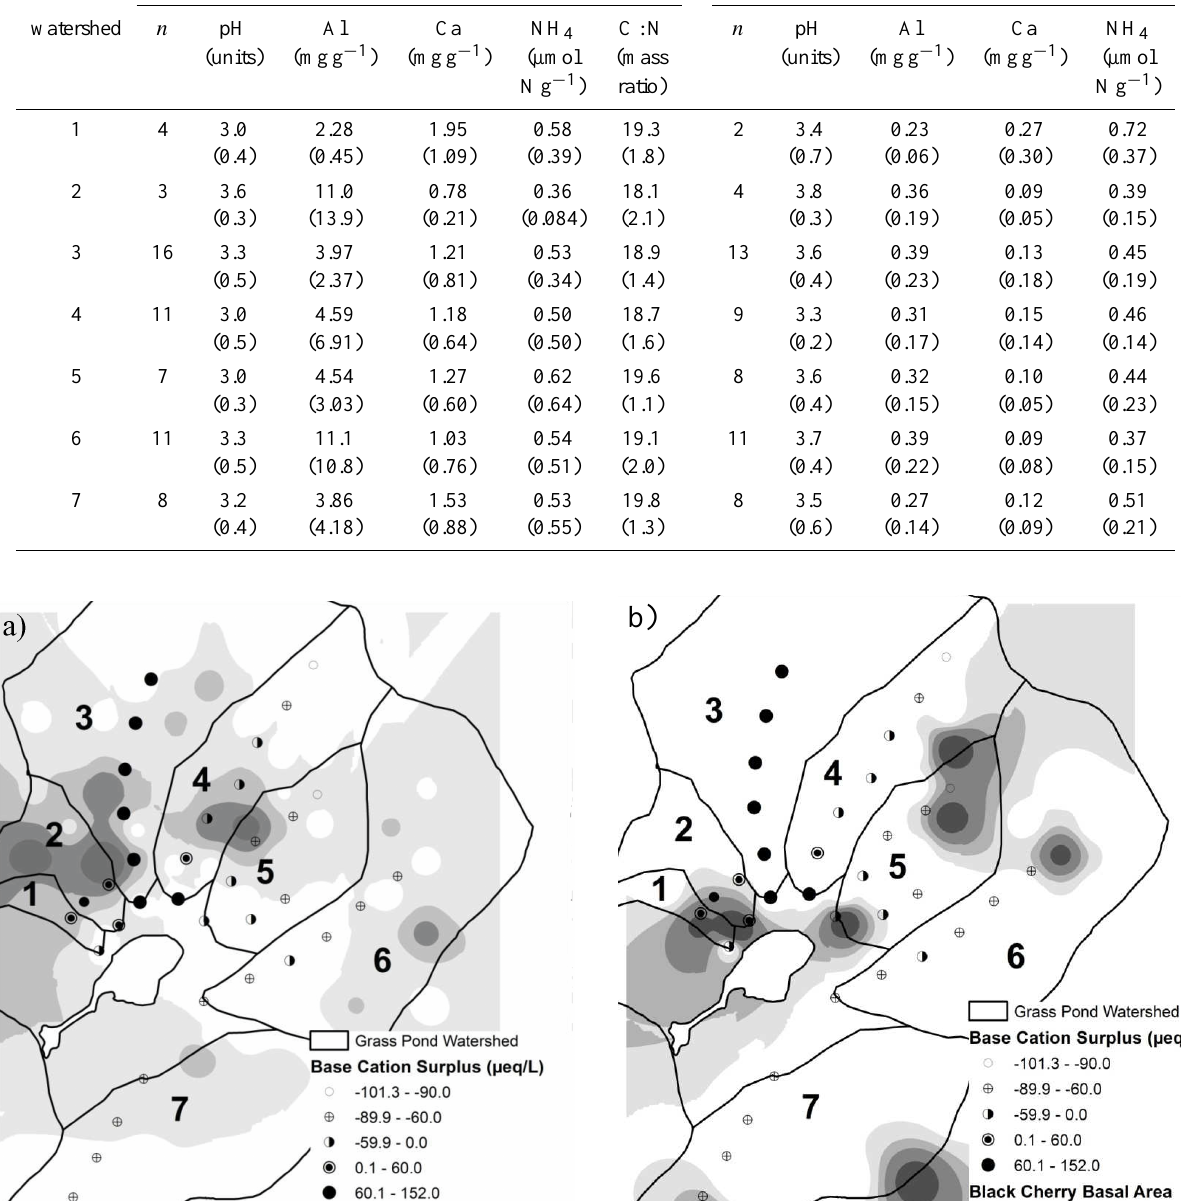
Table 2. Forest floor (total) and mineral soil (exchangeable) chemistry means (standard deviation) for sample plots within Grass Pond subwatersheds. Sub- Forest floor Mineral soil